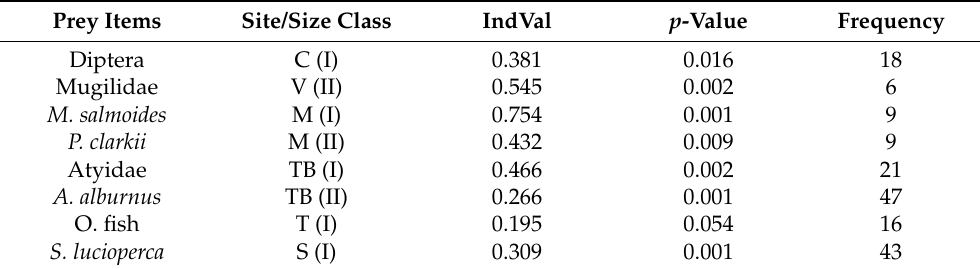
Table 3. Indicator Value (IndVal), p -values and Frequency of prey items consumed by pikeperch Sander lucioperca populations in Portuguese basins between sites and size classes (I ≤ 25 cm, II > 25 cm SL). Population acronyms according to Figure 1.